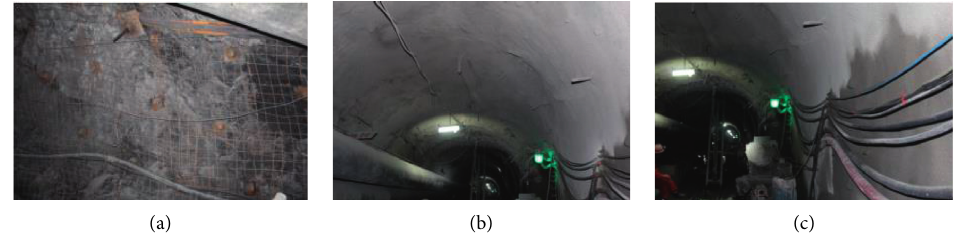
Figure 16: Displacement monitoring results of the surrounding rock around